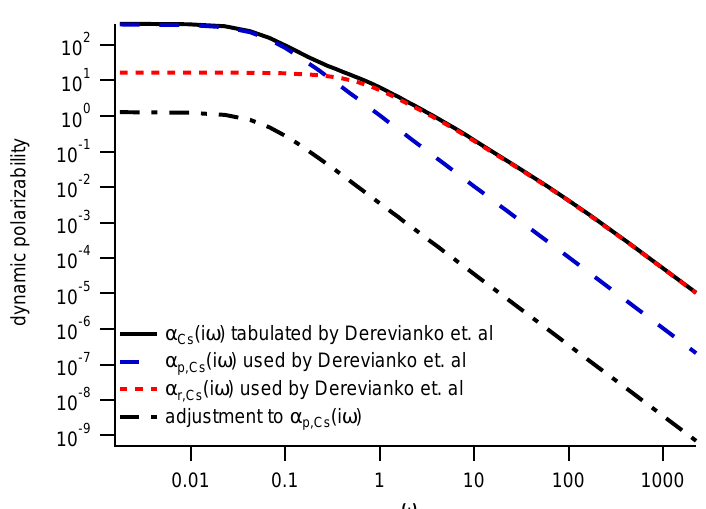
Figure 5. Cesium atom α tab ( i ω ) tabulated in [63] ( black line), and its decomposition into calculated α p ( i ω ) based on τ 1/2 and τ 3/2 values [50] with Equation (2) ( green line) and the residual α r ( i ω ) ( red line). The black dotted line represents the adjustment to α p ( i ω ) when we substitute α ( 0 ) measurement into Equation (23). Axes are in atomic units.